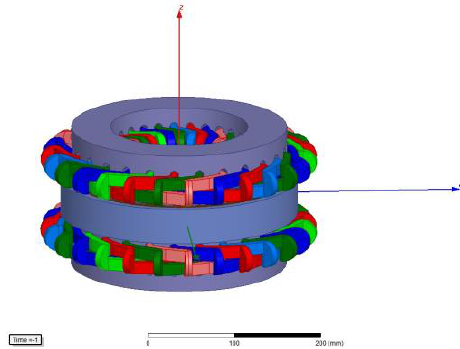
Figure 17. AFPMSM finite element simulation model.